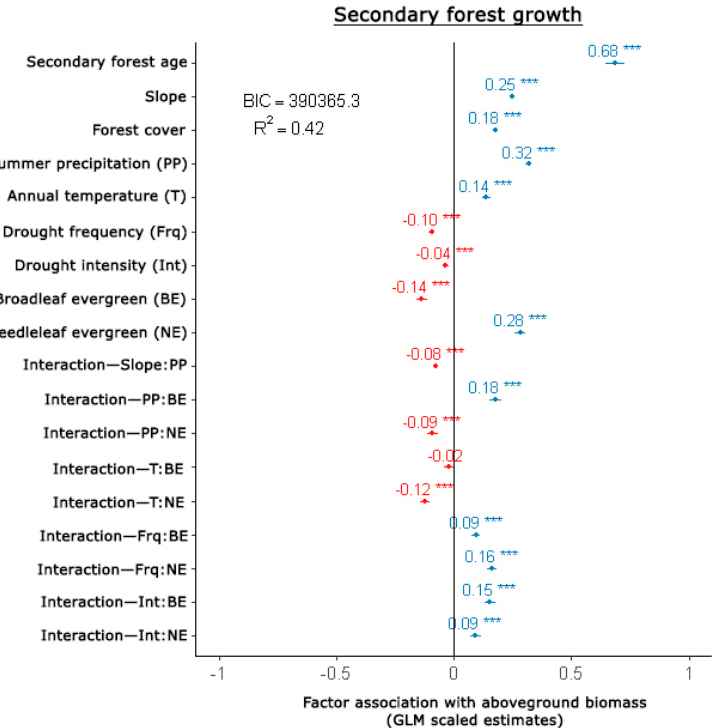
Figure 5. General linear model (GLM) parameter estimates of the relationships between secondary forest growth (aboveground biomass; Mg ha − 1 ) and several explanatory variables, including the logarithm of the secondary forest age (y), slope (°), forest cover in a 1 km radius (%), mean precipi- tation in summer (mm), mean annual temperature (°C), drought frequency (events/year), drought intensity and forest leaf-habit (broadleaf evergreen (BE) and needleleaf evergreen (NE) compared to broadleaf deciduous (BD)). Climatic factors were calculated using the mean of the secondary forest establishment periods (from the quinquennium of establishment up to 2015). Significance is indicated using the following p -values: ***: 0.001.